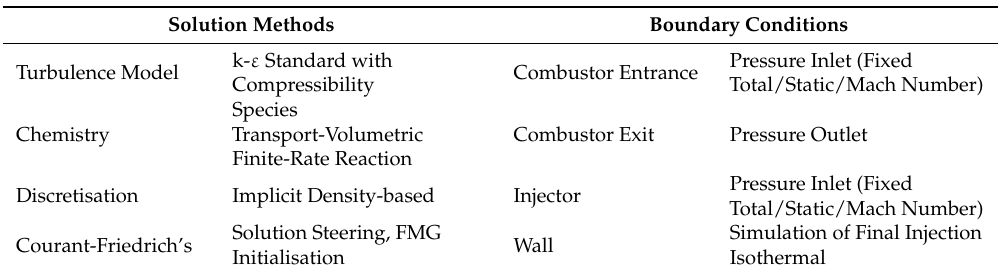
Table 4. CFD solution methods and boundary conditions.